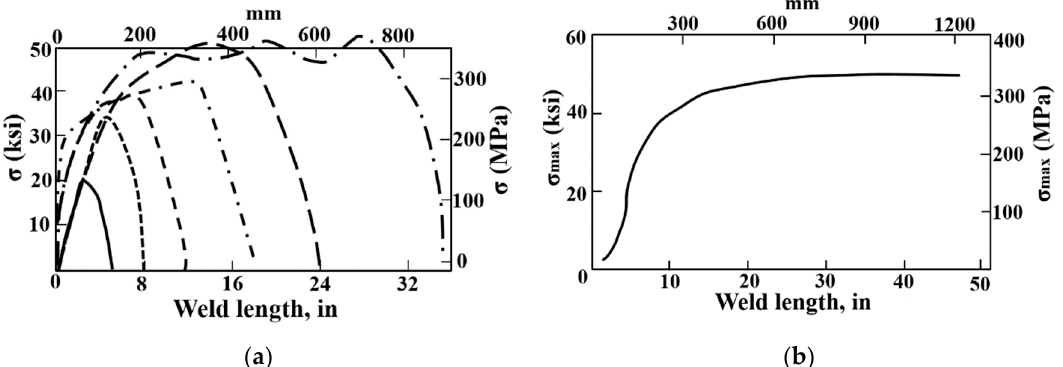
Figure 3. Effect of weld length on longitudinal residual stress (from [23]): ( a ) Longitudinal residual stress distributions; ( b ) maximum longitudinal residual stress.